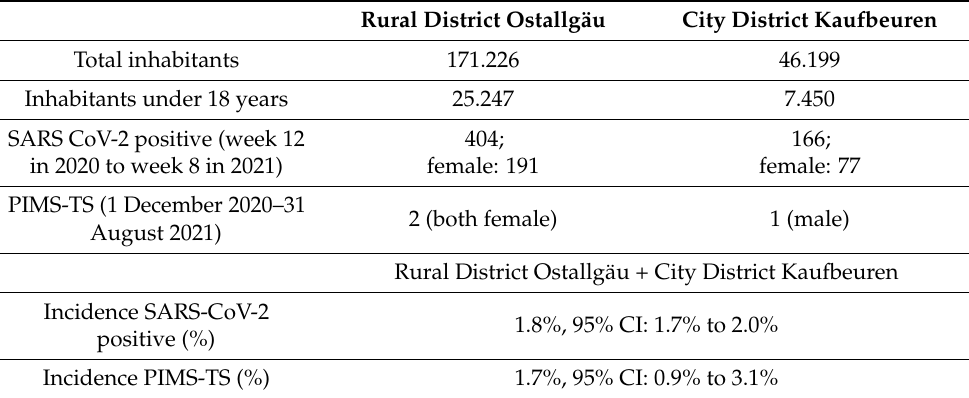
Table 7. Estimated incidence and confidence interval